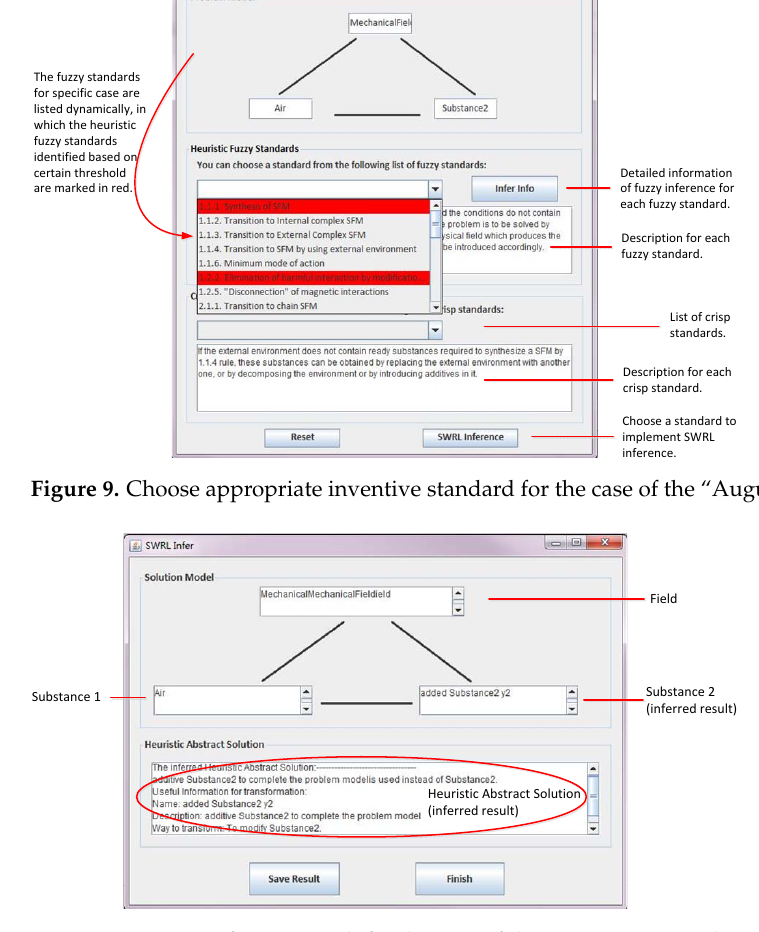
Figure 10. SWRL Inference result for the case of the “Auguste Piccard’s Stratostat”. Taking this into account, a new direction to solve this problem is proposed, that is, introducing a material that let the rope go through but not the air. For example, a liquid let solid parts go through but not air, as shown in Figure 11a. However, if a liquid is used at the top of the sphere, it will fall at the bottom, as depicted in Figure 11b.